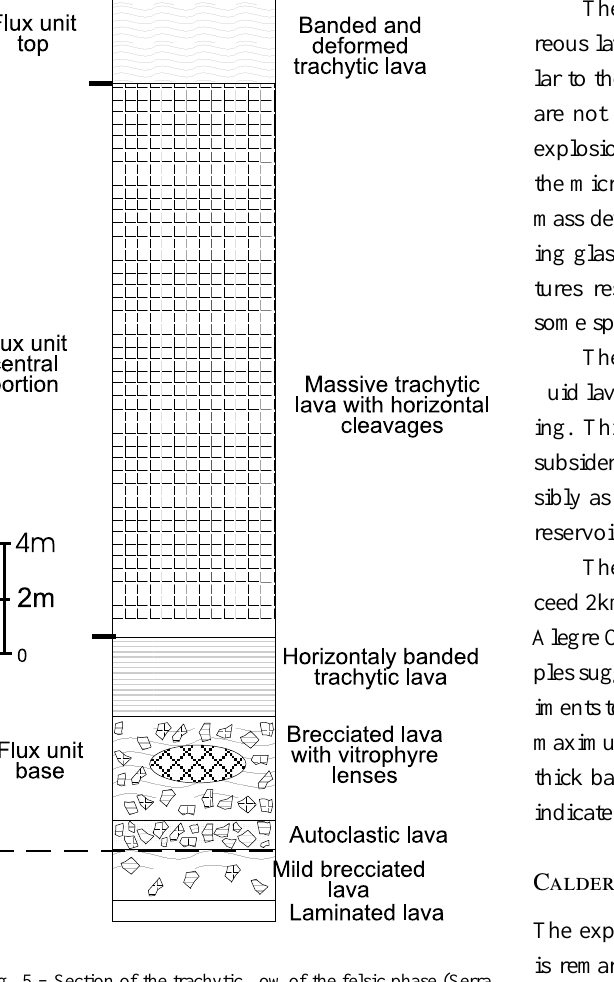
Fig. 5 – Section of the trachytic flow of the felsic phase (Serra de São Miguel Formation) located at Clube Tigre, showing the distribution of the different facies of these